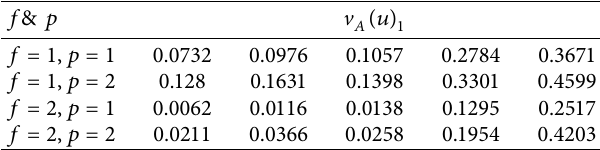
Table 6: The comprehensive relative membership vector.